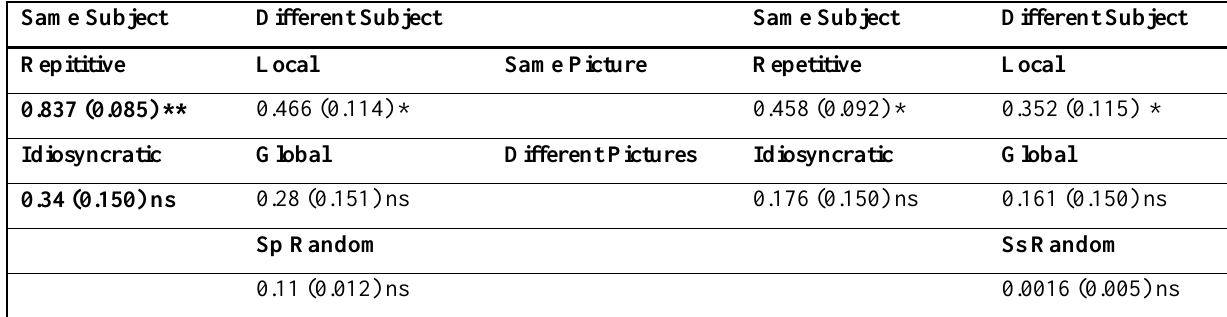
Table 2: Overall parsing diagram for Sp (position) and Ss